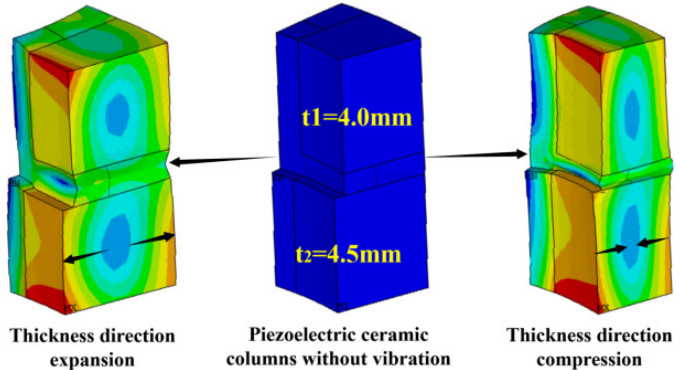
Figure 5. Different vibration modes of piezoelectric composite rings.